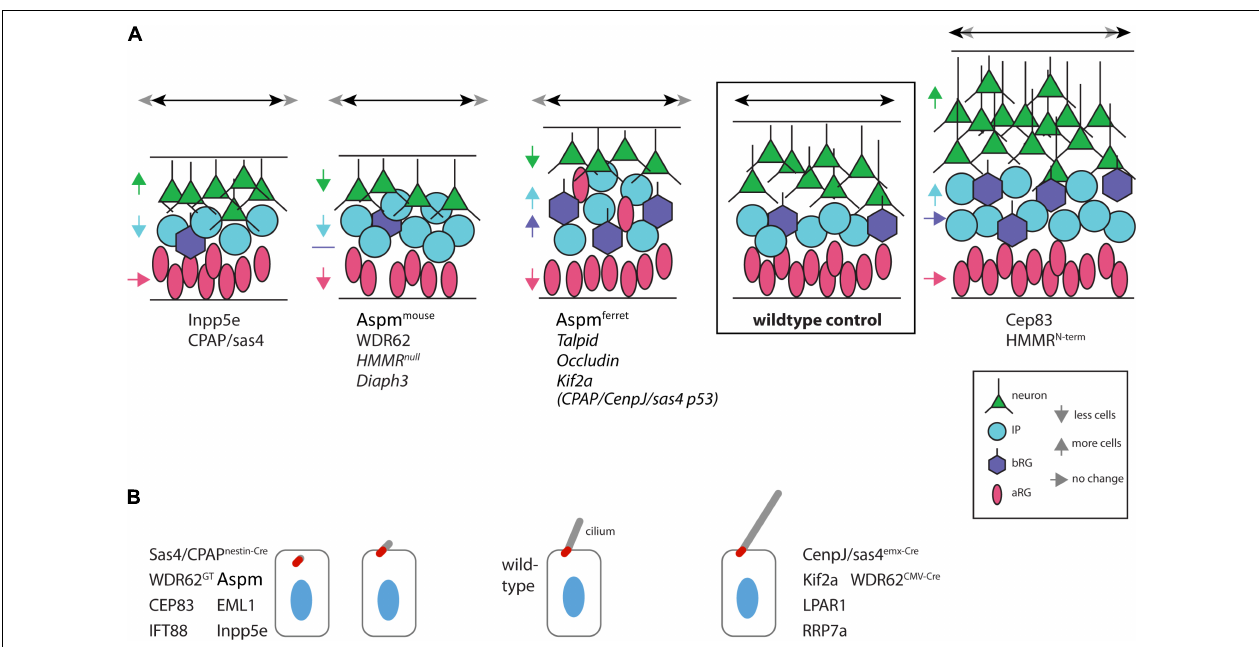
FIGURE 2 | Range of phenotypes of mutations pertaining to primary cilia/centrosomes. (A) Schematic representation of the abundance of various cell types in the developing neocortex. The progenitor and neuron compositions of the developing neocortex upon mutation/knockdown of various genes are indicated. Names in italics indicate the lack of information on the abundance of bRGs in the mutant neocortex. Colored arrows indicate the change in abundance of the correspondingly colored cell type. Black double-sided arrows at the top indicate the changes in lateral expansion, with the width of the wildtype cortex (gray double-sided arrow) for comparison. Superscripts indicate species or mutation. Apical is down. (B) Primary cilium length. Schematic representation of the length of primary cilia (gray, basal body in red) of cells (nuclei in blue) in the developing neocortex as observed upon the indicated mutations. Superscripts indicate the conditional knockout conditions. Apical is